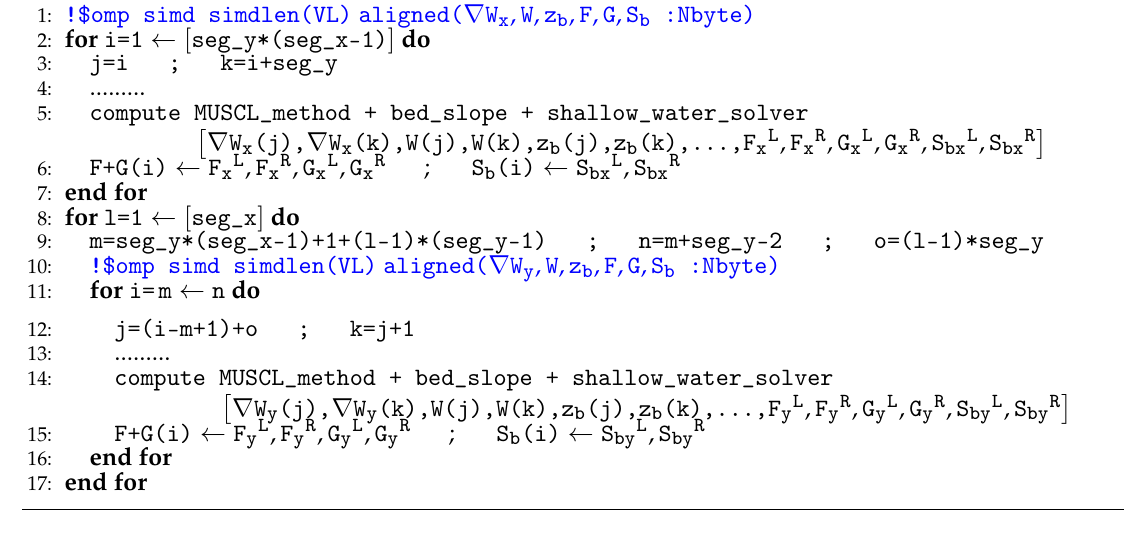
Algorithm 3 Pseudo-code for SUBROUTINE edge-driven_level (only for internal